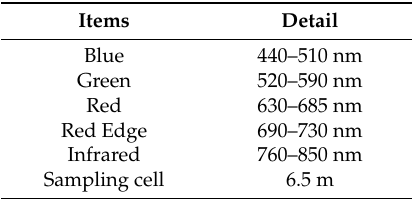
Table 1. Image bands and sampling cell size.